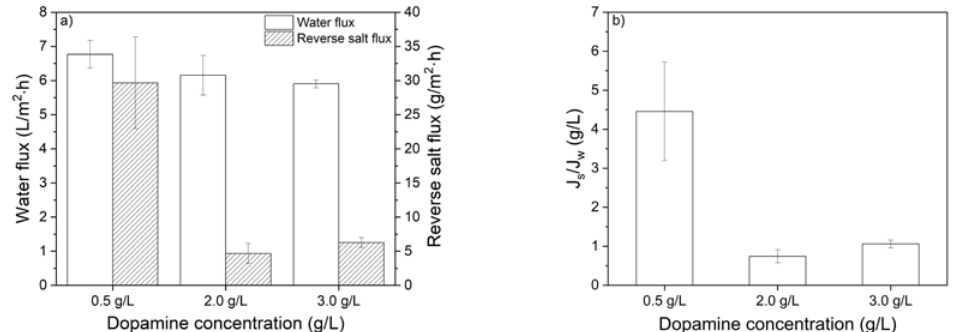
Figure 9. Effect of dopamine concentration on ( a ) water flux and reverse salt flux and ( b ) specific reverse salt flux (J s /J w ) of the membranes investigated. Coating temperature: 25 °C. Feed solution: UPW. Draw solution: 1.2 M MgSO 4 . Co-current cross flow: 25 cm/s. Average values and standard deviations represent two replicate samples.